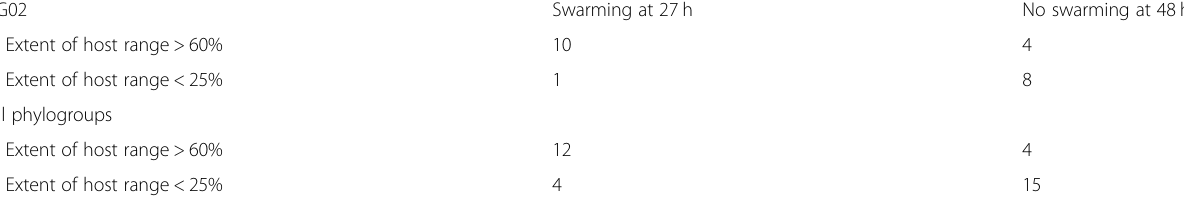
Table 4 The number of strains of Pseudomonas syringae in phylogroup 2 and for all phylogroups considered together according to their host range extent and capacity to swarm on semi-solid nutrient medium. In both cases, there is a significant interaction of host range extent and swarming (Fisher ’ s exact test, P < 0.01). There were not sufficient strains to test the interaction of swarming and